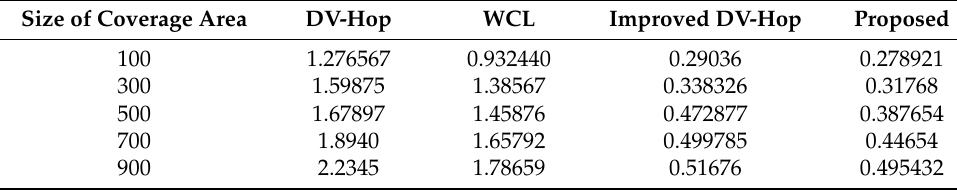
Table 10. Coverage area vs. average localization